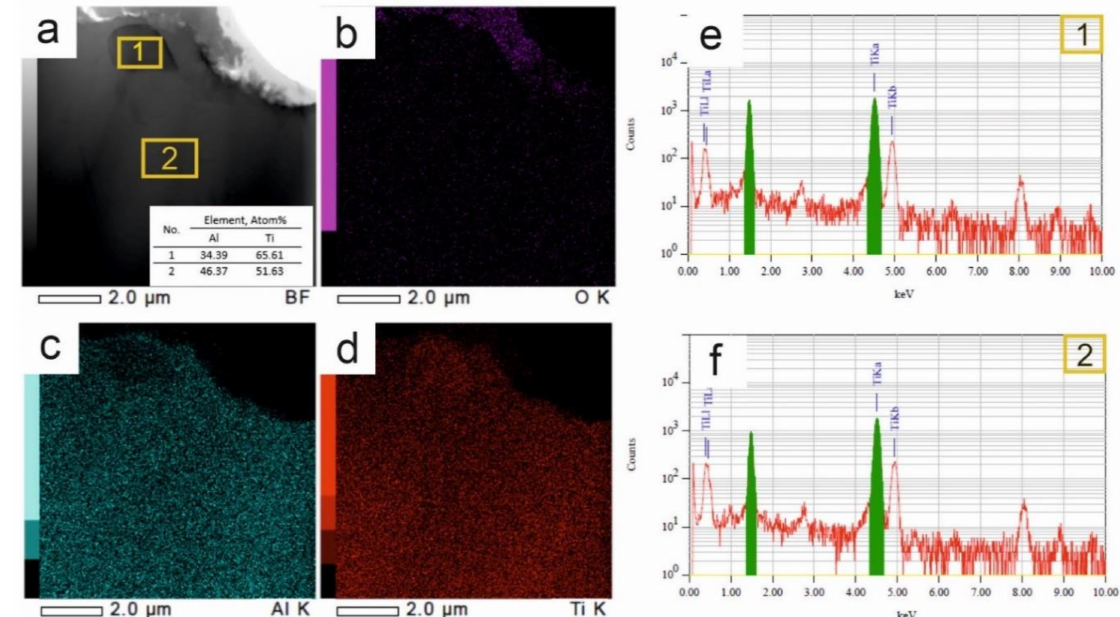
Figure 4. TEM images of the Ti-Al alloy ( a ) with super-spectral surface ( b – d ) and with energy-dispersive spectral analysis (EDS) spectrum of relevant areas (1)— e , and (2)— f